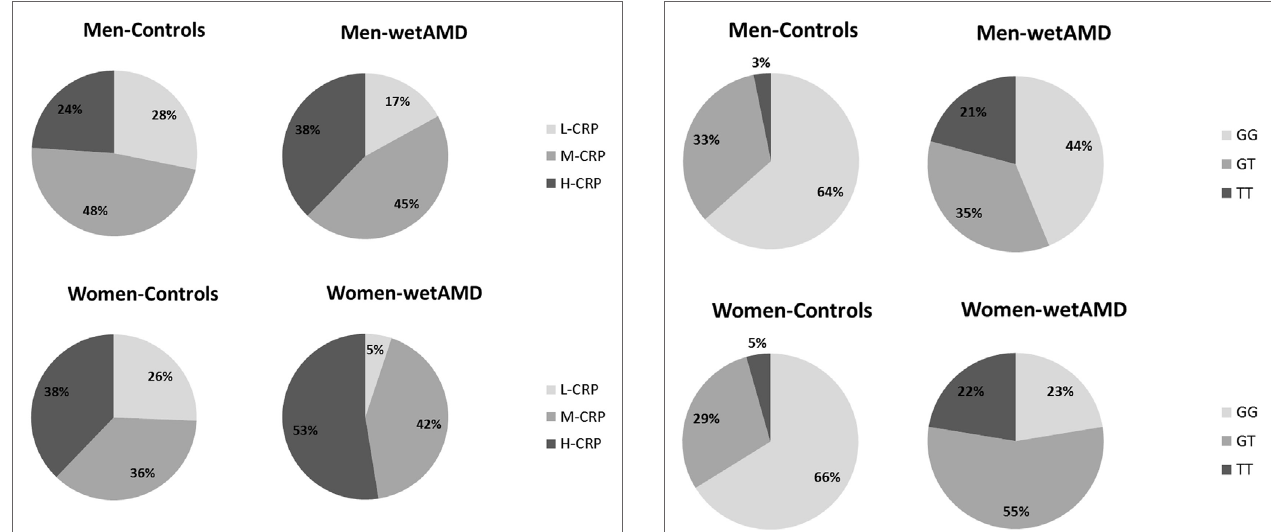
FigUre 2 | Percentage of individuals according to A69S genotypes divided by gender (men: upper row and women: lower row) and study groups (controls: left column and wetAMD: right column). L-CRP (low C-reactive protein, < 1 mg/L; light gray), M-CRP (moderate C-reactive protein, 1.0–3.0 mg/L; medium gray), and H-CRP (high C-reactive protein, 3.0– 10.0 mg/L; dark gray). Letters T and G: nucleotides for the ARMS2 A69S.